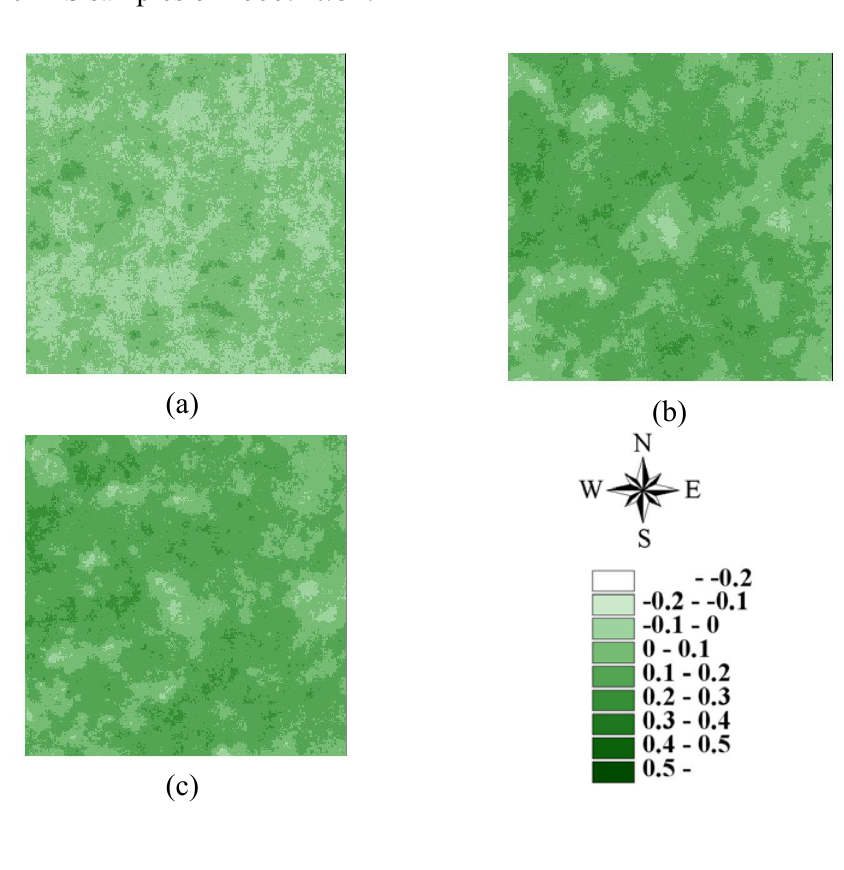
Figure 13. Conditional simulated NDVI images for area B based on (a) 100, (b) 500, and (c) 1,000 cLHS samples on